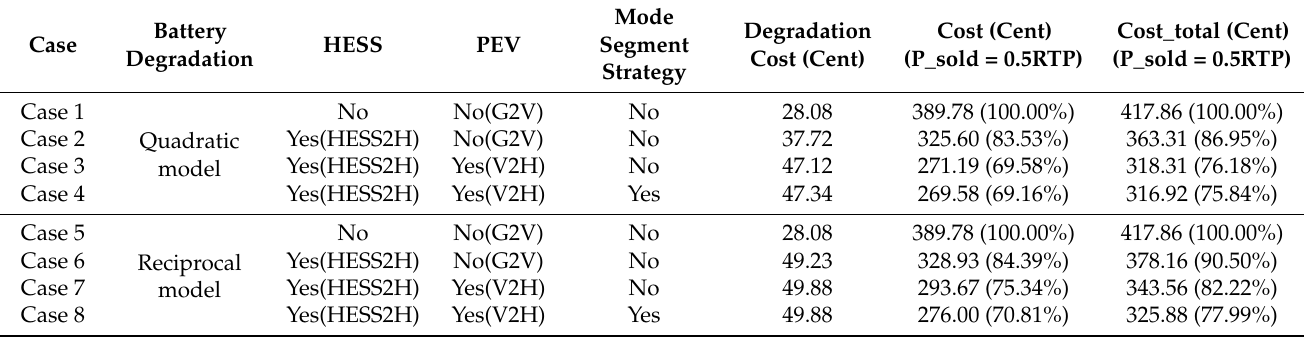
Table 4. Case comparison results.